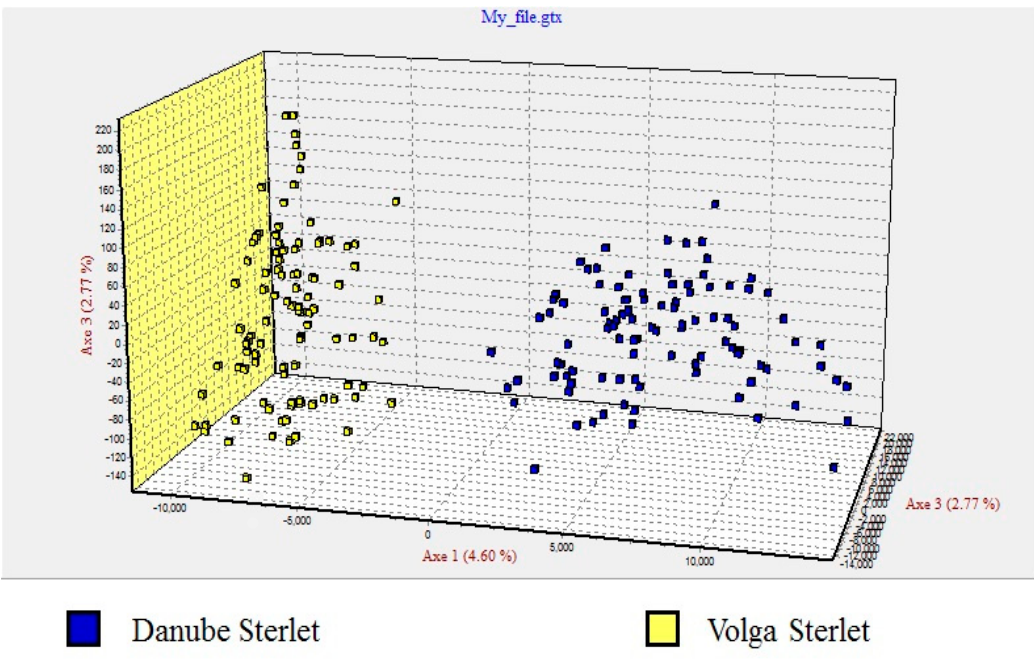
Figure 2. Factorial correspondence analysis based on six microsatellite loci illustrating genetic relationships among the Danube sterlet (blue squares) ( n = 100) and Volga sterlet (yellow squares) ( n = 100).